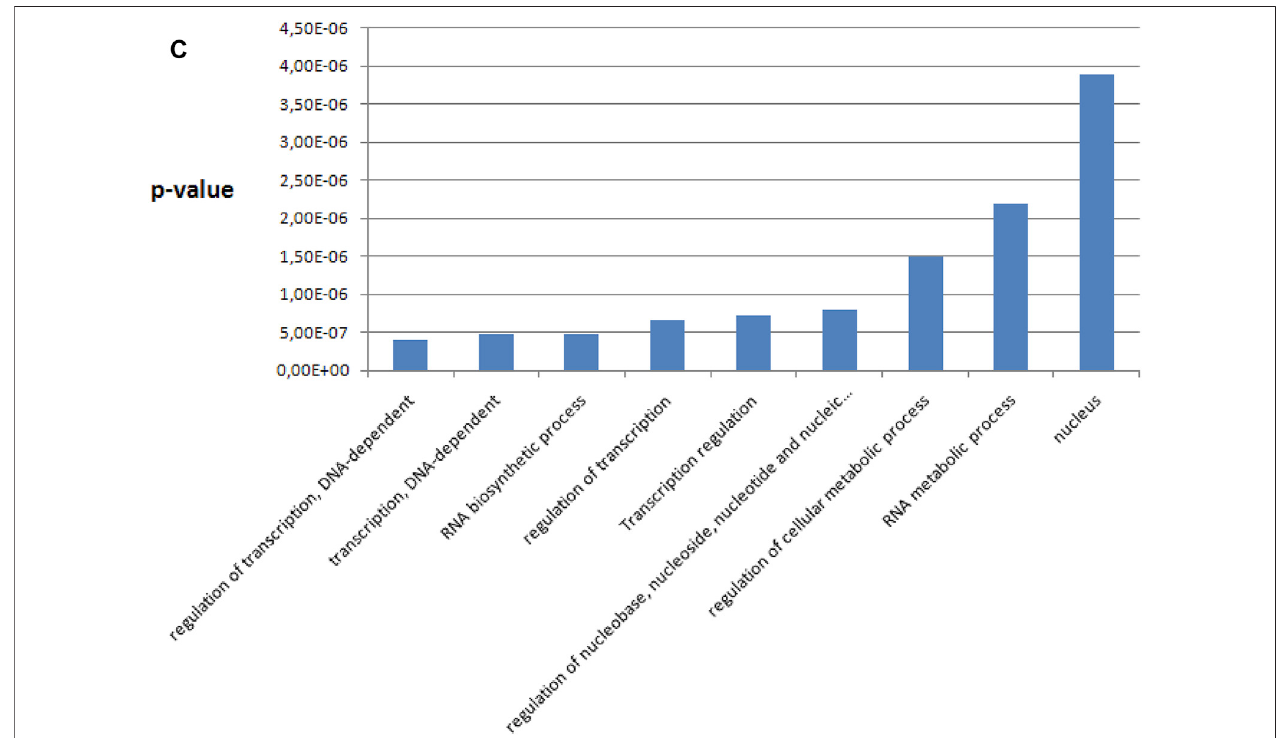
Figure 3B : First, the network neighborhood suggests that ctag1b/a (aliased as ctag2 in the sub-network), prame and magec1 , form a clique. Also, prame is linked to six1 and ctag2 to ranbp2 .